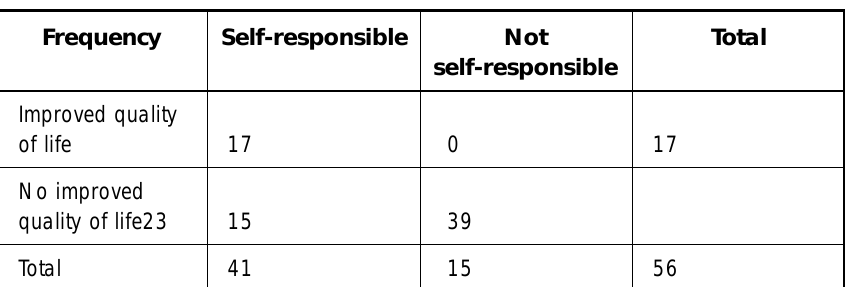
Table V1: Self-Responsibility In Patients With Improved Quality Of Life One Year After CABG.